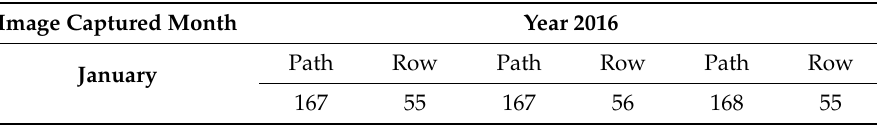
Table 1. Acquired Landsat satellite image Table 1 . Acquired Landsat satellite image characteristics .